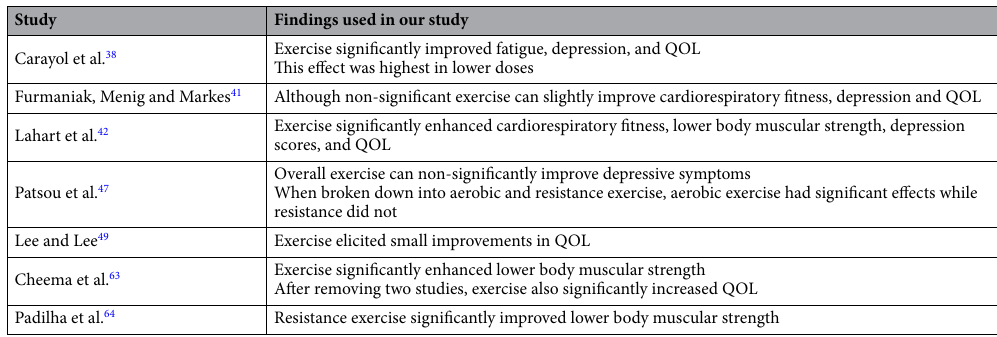
Table 3. Other meta-analyses that support present